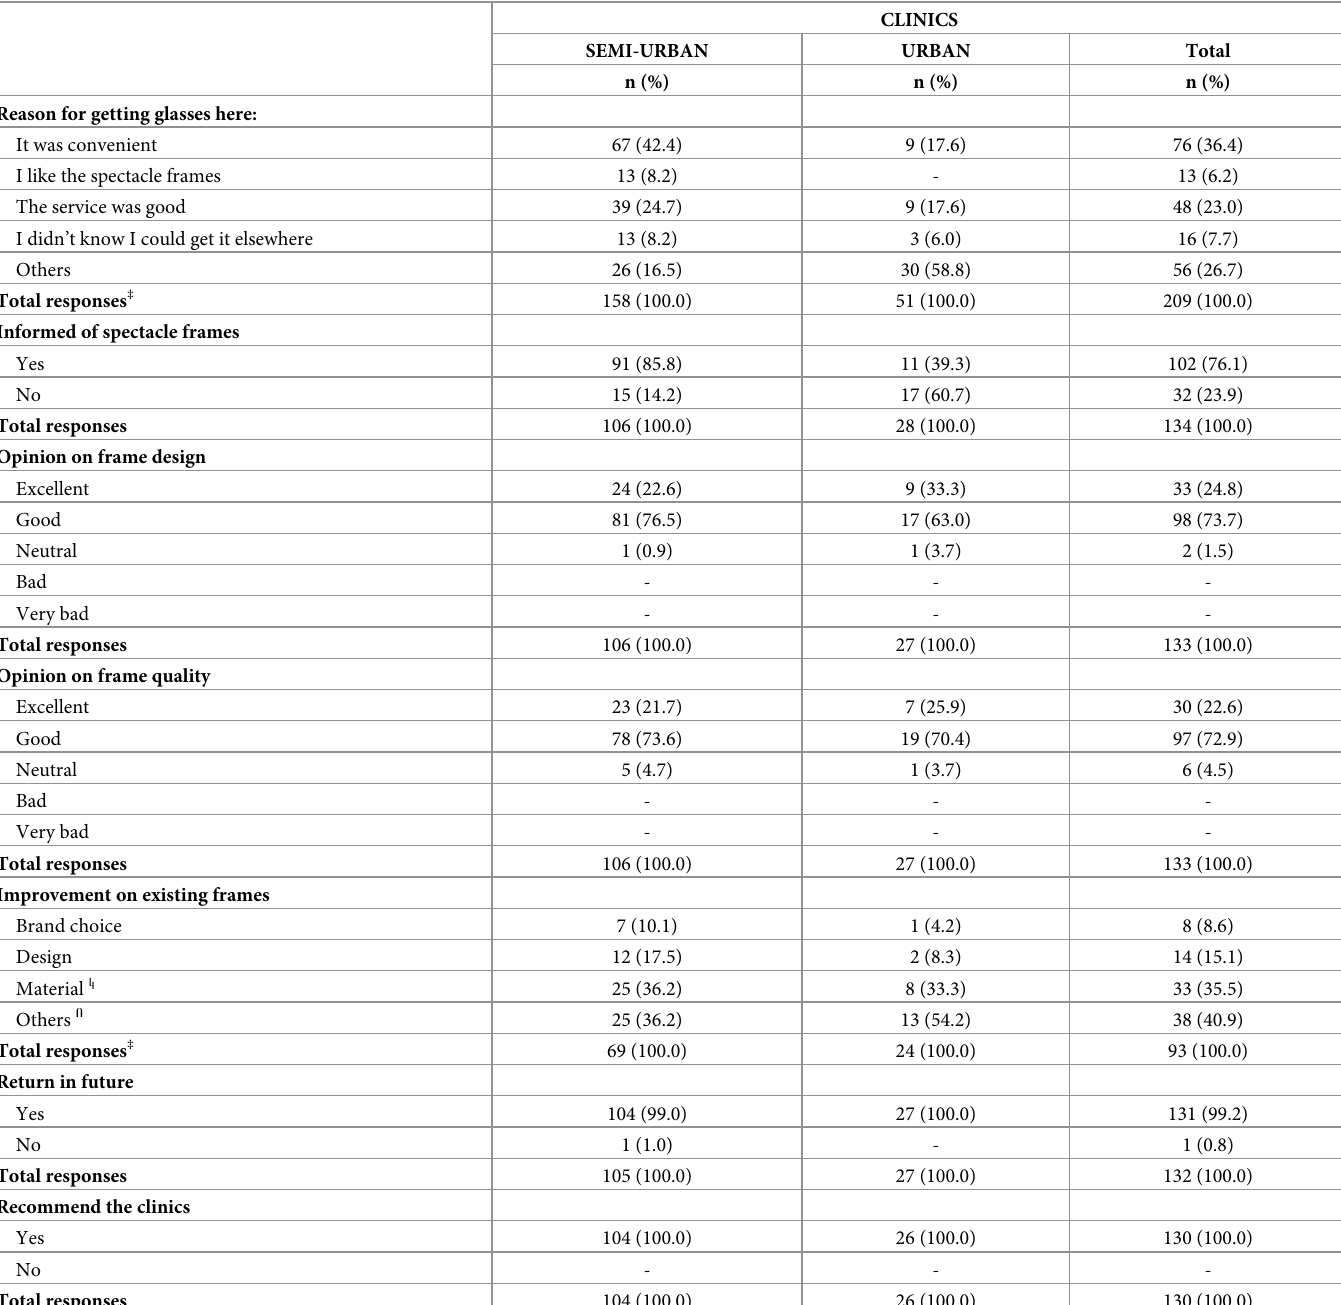
Table 2. Participants’ feedback on the existing services provided at the child eye